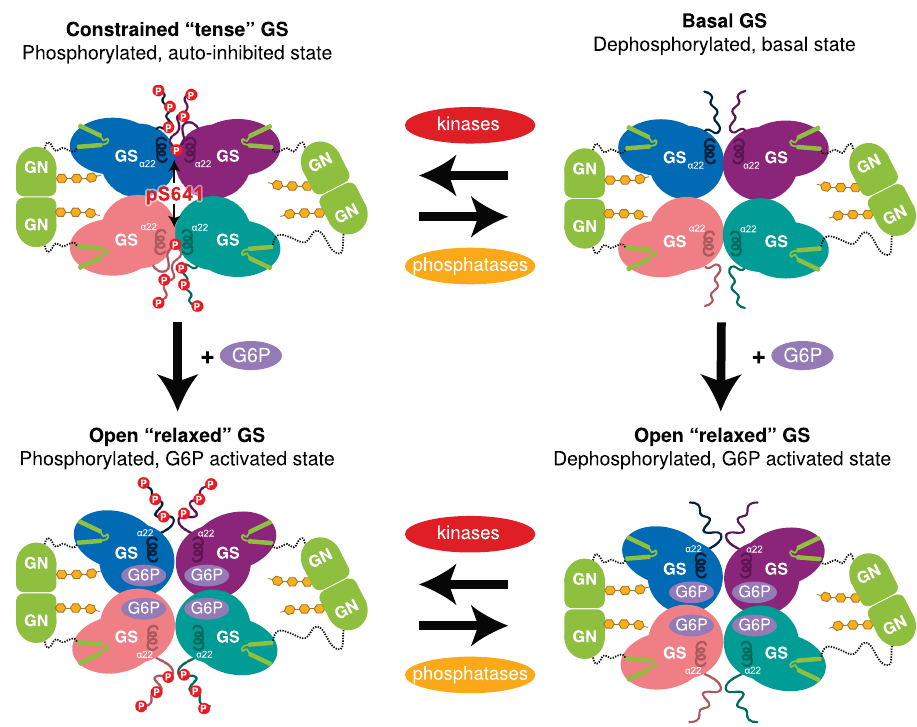
Fig. 5 GS and GN cooperate to synthesise glycogen. Glucose is converted into glycogen through the action of glycogenin (GN), glycogen synthase (GS) and glycogen branching enzyme (GBE). GN interacts with GS to feed the initial glucose chain into the GS active site for elongation. GS is regulated by allosteric activation and inhibitory phosphorylation. Phospho-S641 (pS641) from one C- terminal tail interacts with the regulatory helices α 22 to cause enzyme inhibition. This can be relieved by glucose-6-phoshate (G6P), with or without phosphatases, to reach a high activity state. Kinases can phosphorylate GS to inhibit the